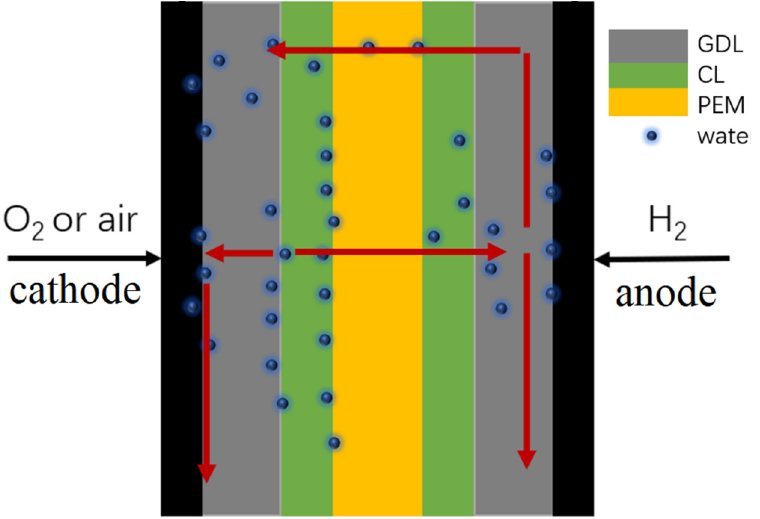
Figure 1. Schematic diagram of water diffusion in fuel cells. GDL is a gas diffusion layer, CL is a catalytic layer, and PEM is a proton exchange membrane. The red scissors in the figure are the movement directions of the water diffusion, electrical drag back, and transmembrane transport from the production site.